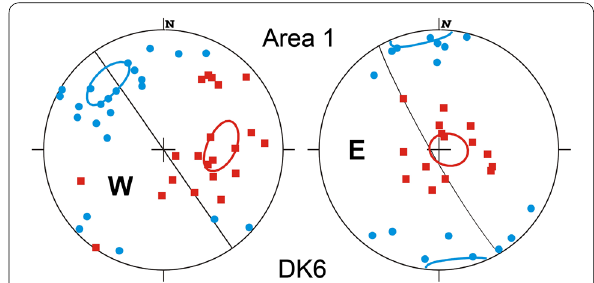
Fig. 8 AMS stereoplots for dike DK6 (Area 1). Maximum (blue squares) and minimum (red circles) susceptibility axes with confidence zone at 95% (Henry and Le Goff 1995) at the western (W) and eastern (E) margins of the dike. Orientation of the dike plane is indicated by a great circle (Schmidt diagrams, lower